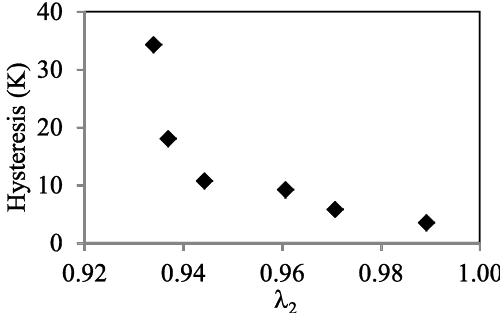
Figure 6. Thermal hysteresis versus middle eigenvalue of the transformation stretch matrix (λ 2